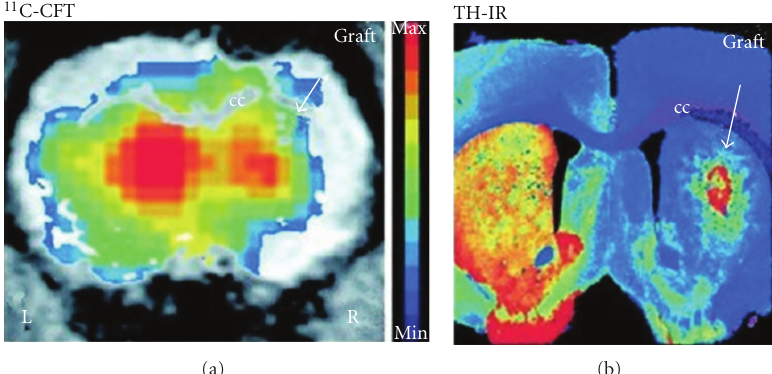
Figure 2: The specific dopamine transporter (DAT) ligand [ 11 C] CFT binding in the right grafted striatum was detected using PET, as shown in this brain slice (a). Increased [ 11 C] CFT binding was found in the right striatum, which may correlate with the postmortem presence of TH-immunoreactive (IR) neurons in the graft (b). Color-coded (activity) PET images were overlaid with MRI images for anatomical localization